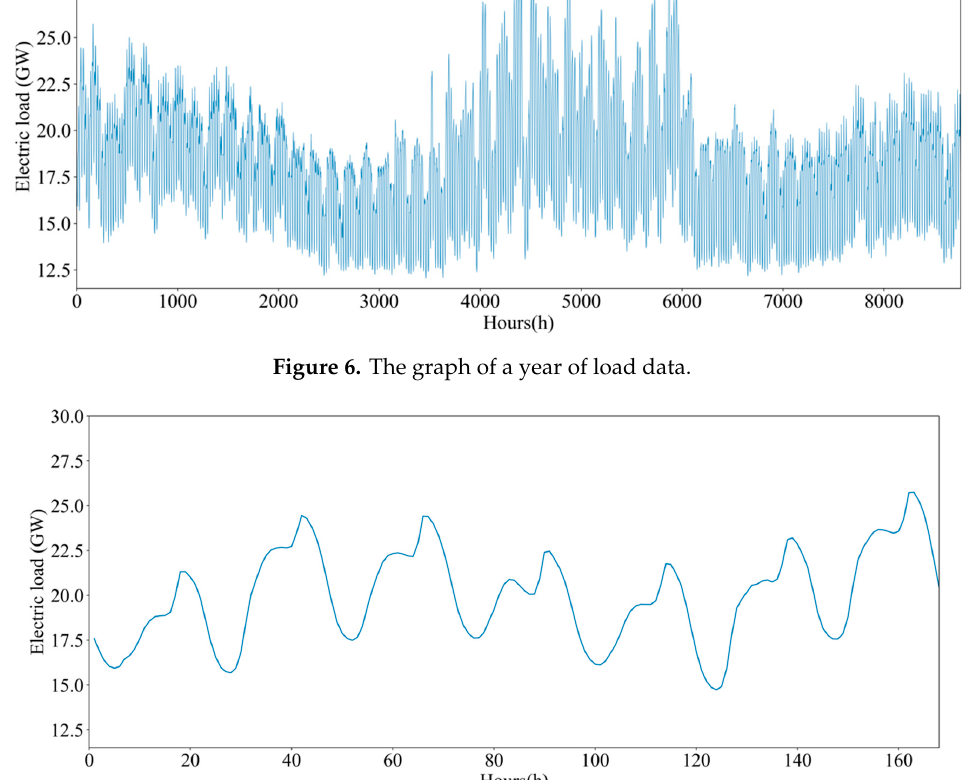
Figure 7. The graph of a week of load data.